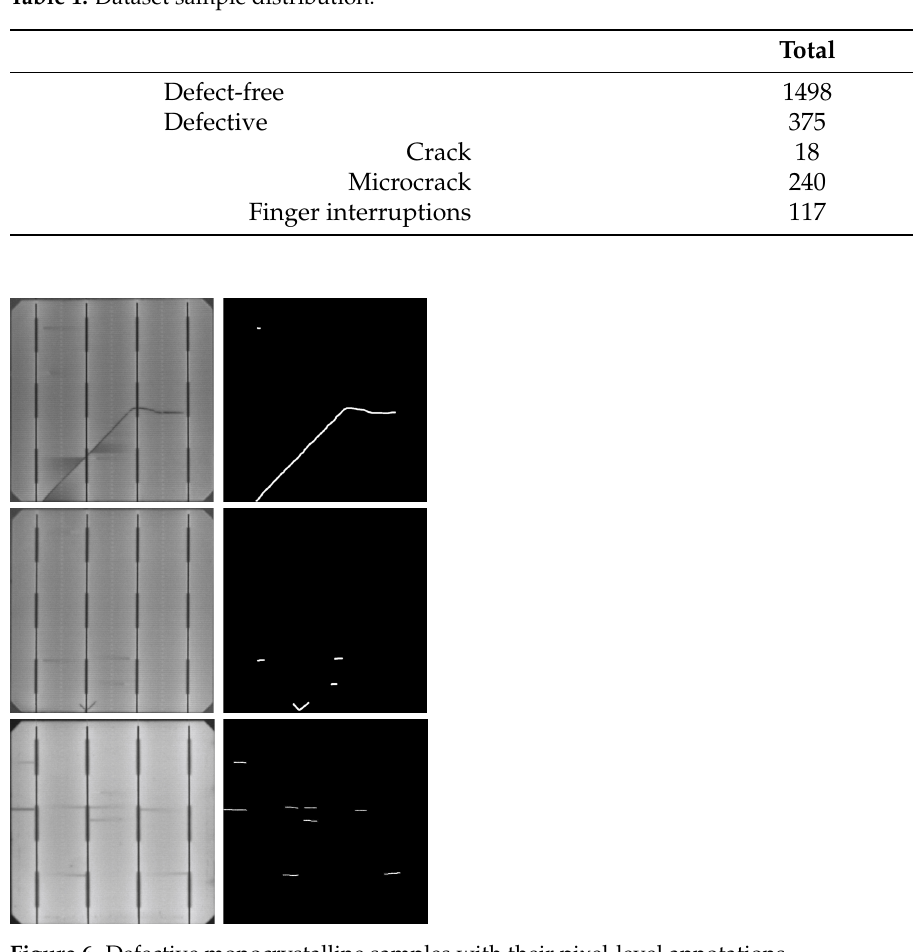
Table 1. Dataset sample distribution.